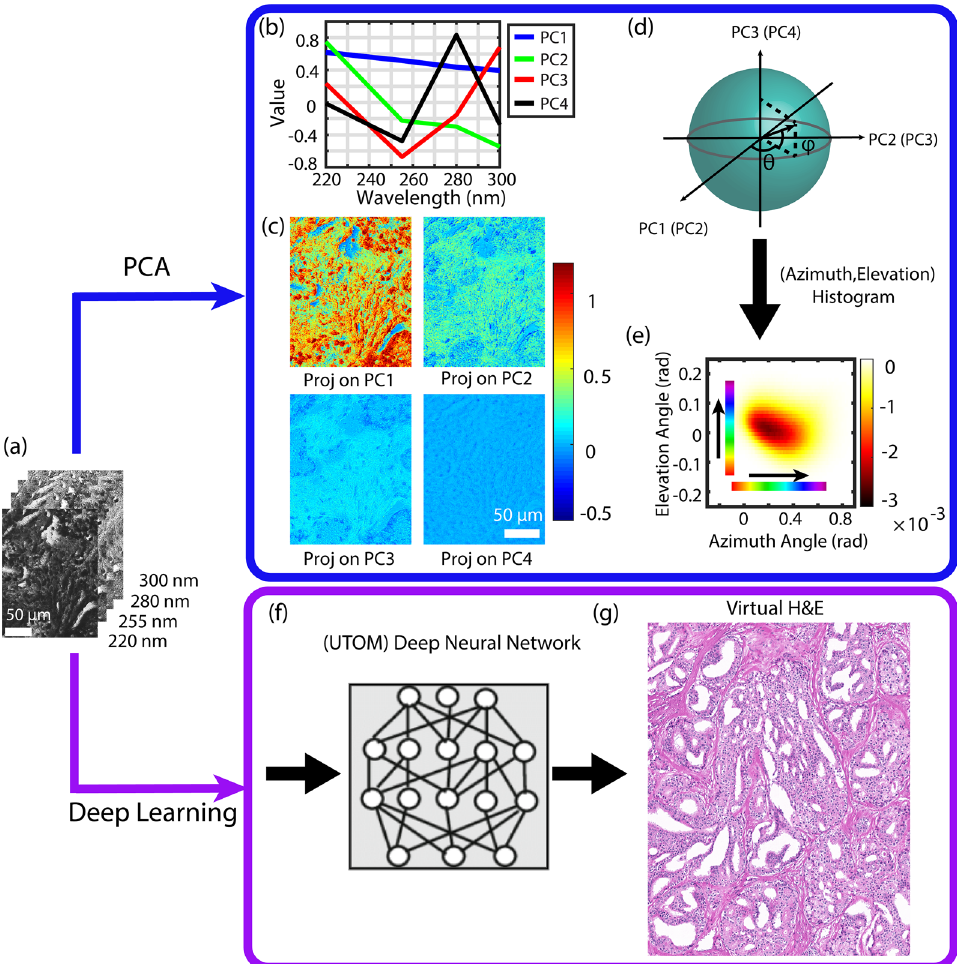
Figure 1. Processing of multi-spectral deep UV images using the two proposed methods. Top: geometrical representation of principal component analysis. Bottom: Unsupervised content-preserving transformation for optical microscopy. ( a ) A representative multi-spectral deep UV transmission data cube taken at 220, 255, 280 and 300 nm. ( b ) The 4 principal components resulting from 130 million spectra from representative select regions. ( c ) Calculated projections of the data cube on the principal components. ( d ) Schematic of data conversion from Cartesian to Spherical coordinates. ( e ) Representative 2D histogram of a data cube using azimuthal and elevation coordinates. ( f ) Schematic of trained Neural network. ( g ) Representative virtually H&E stained prostate tissue (Network